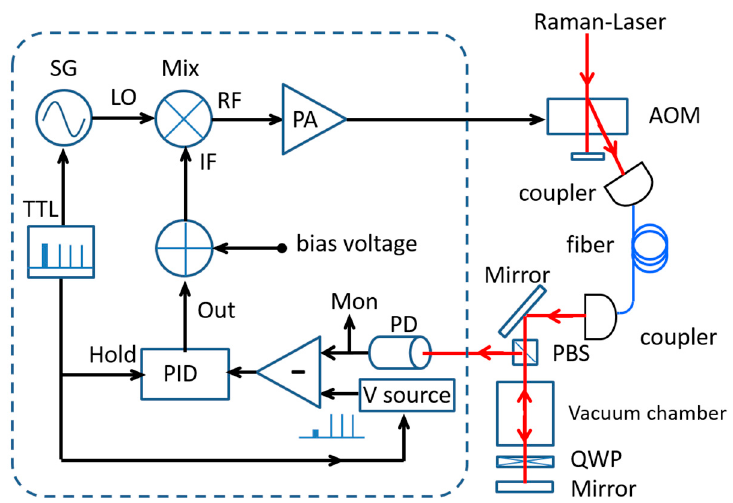
Figure 6. Power of the Raman laser in free running.